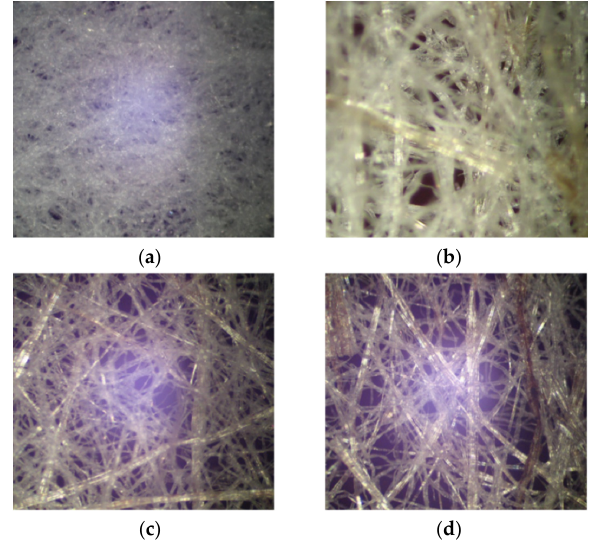
Figure 5. Effect of flax fiber (10 mm) contents on the fibrous network structure, SD = 28.92 g/mm 2 . ( a ) 6g Kraft; ( b ) 1.5 g Flax (10 mm) + 4.5 g Kraft; ( c ) 3g Flax (10 mm) + 3 g Kraft; ( d ) 4.5 g Flax (10 mm) + 1.5 g Kraft.